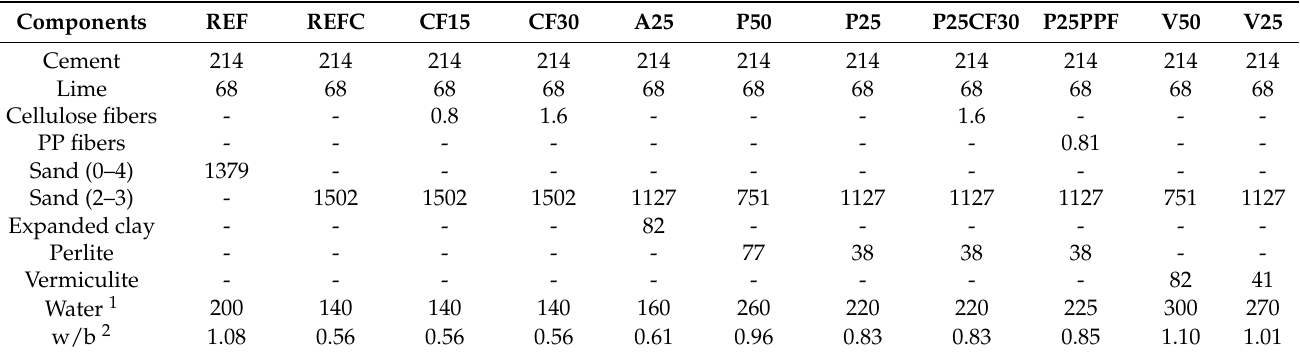
Table 1. Components in kg for a batch of 1 m 3 of multiscale porous lime-cement mortars (adapted from [6]).